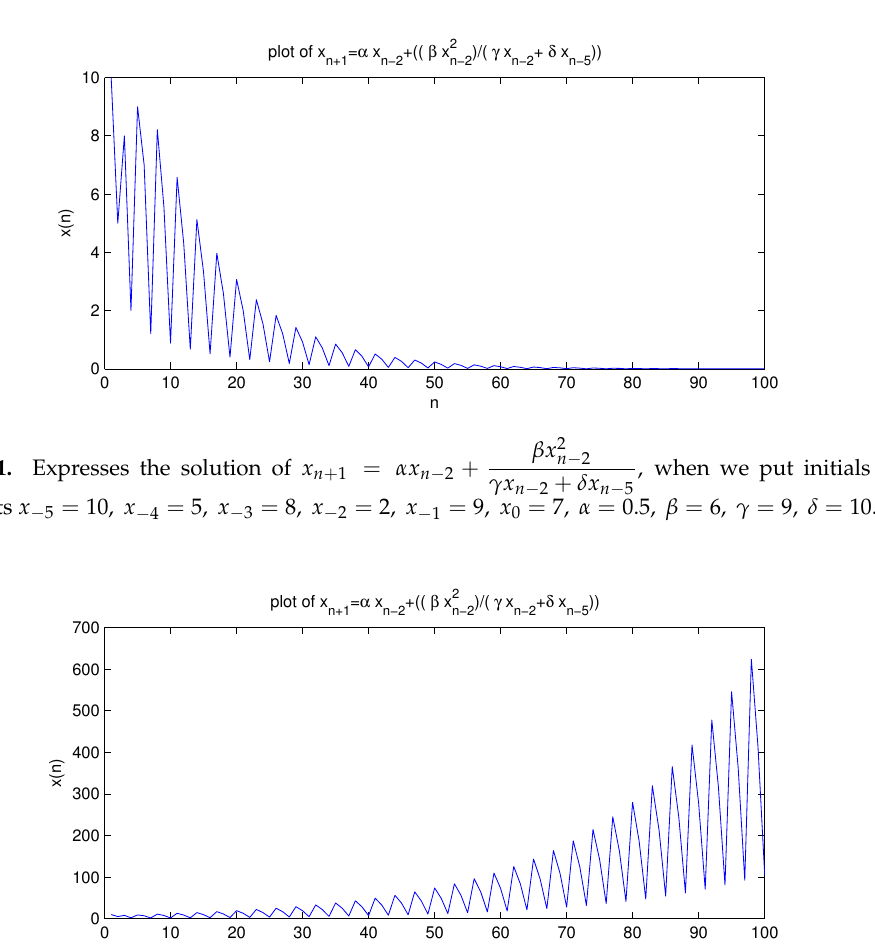
Figure 2. Represents behavior of Equation (1.1) when x − 5 = 10, x − 4 = 5, x − 3 = 8, x − 2 = 2, x − 1 = 9, x 0 = 7, α = 0.6, β = 6, γ = 7, δ =